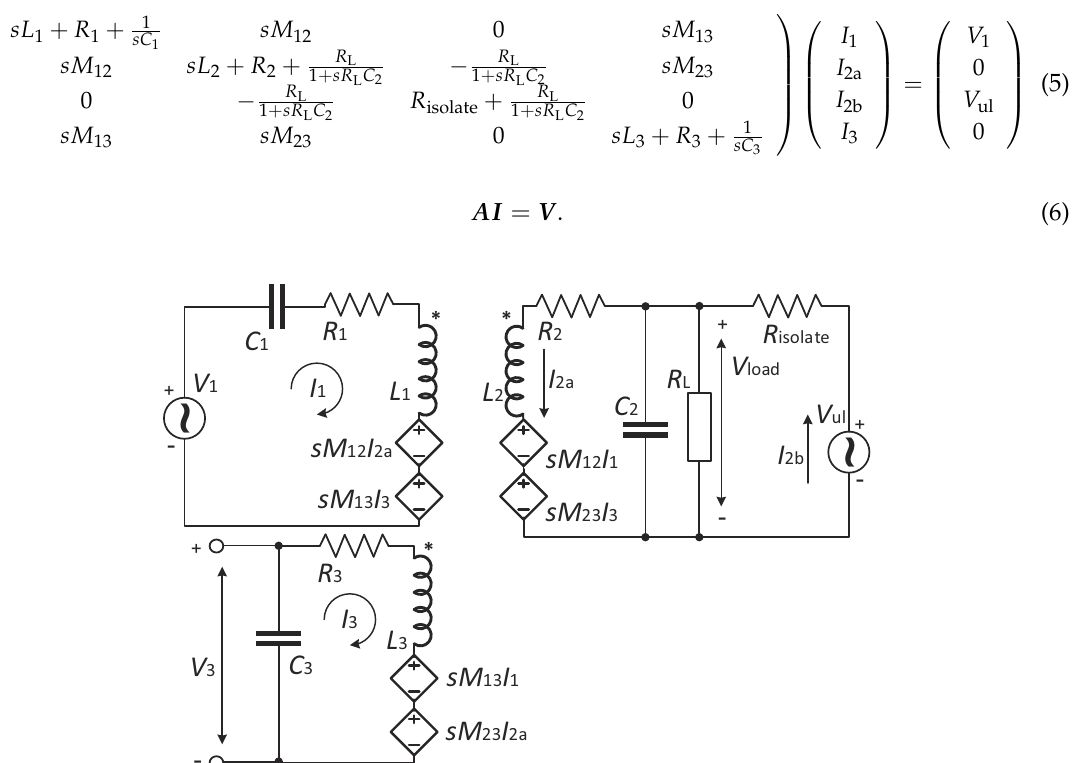
Figure 4. Equivalent circuit model of the magnetic-balanced inductive link